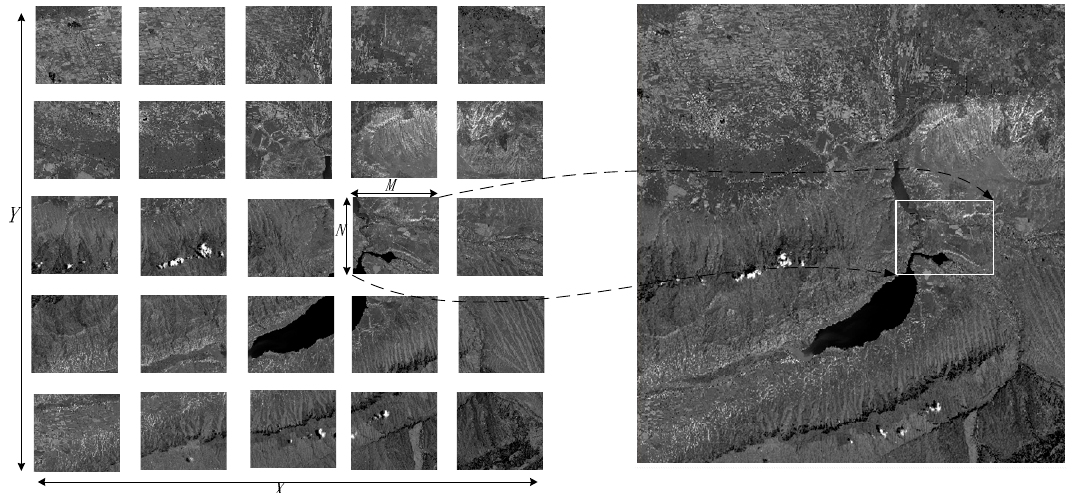
Figure 3. Divide the reference image into blocks and predict the corresponding block in the sensing image.